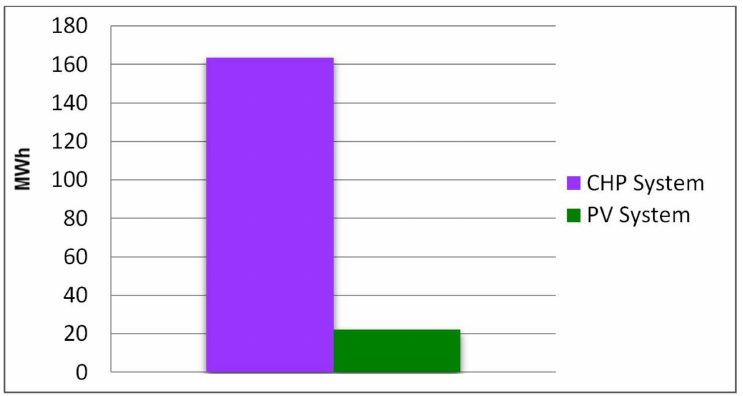
Figure 12. On-site electricity generation.